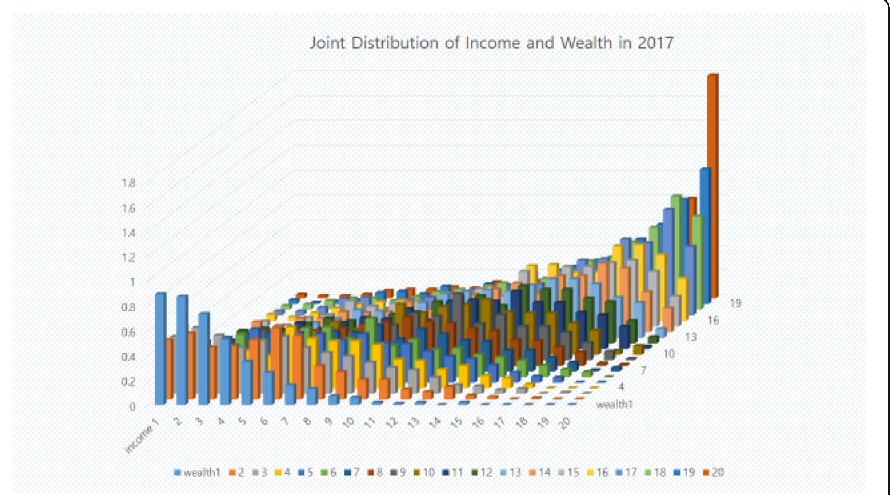
Fig. 2 Joint distribution of income and wealth in